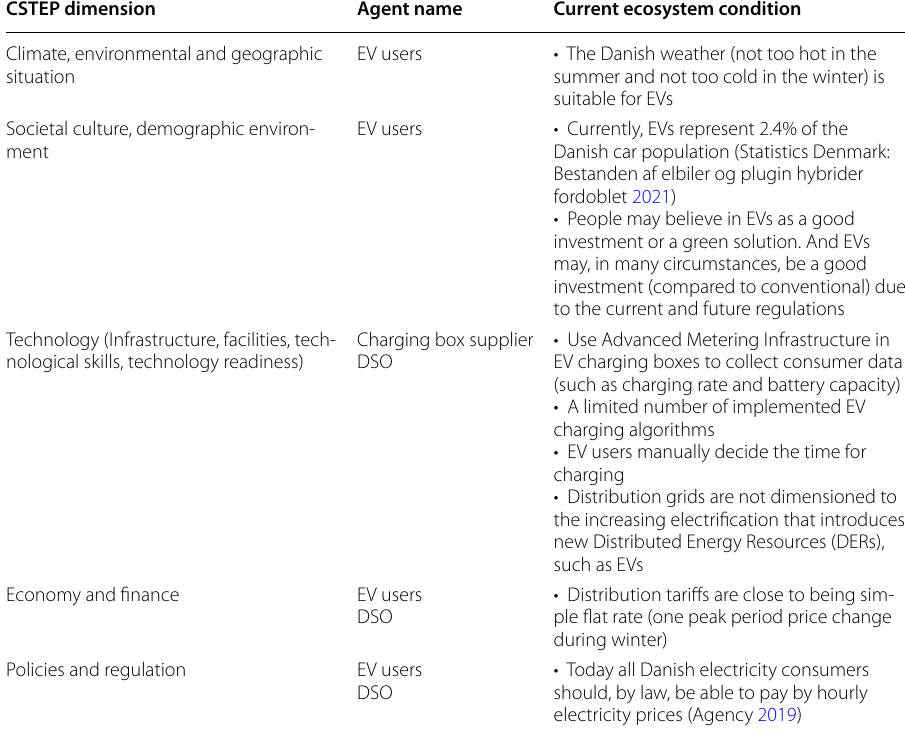
Table 21 Investigation result of related CSTEP dimensions for business ecosystem elements CSTEP